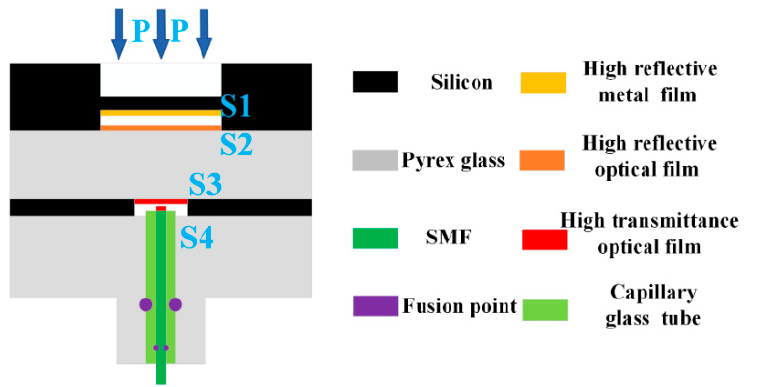
Figure 1. The structure diagram of the proposed fiber-optic Fabry–Perot pressure sensor. Due to the two high-reflectivity surfaces of the Fabry–Perot cavity, high-fineness interference peak signals can be obtained by multi-beam interference. The multi-beam interference can be expressed as